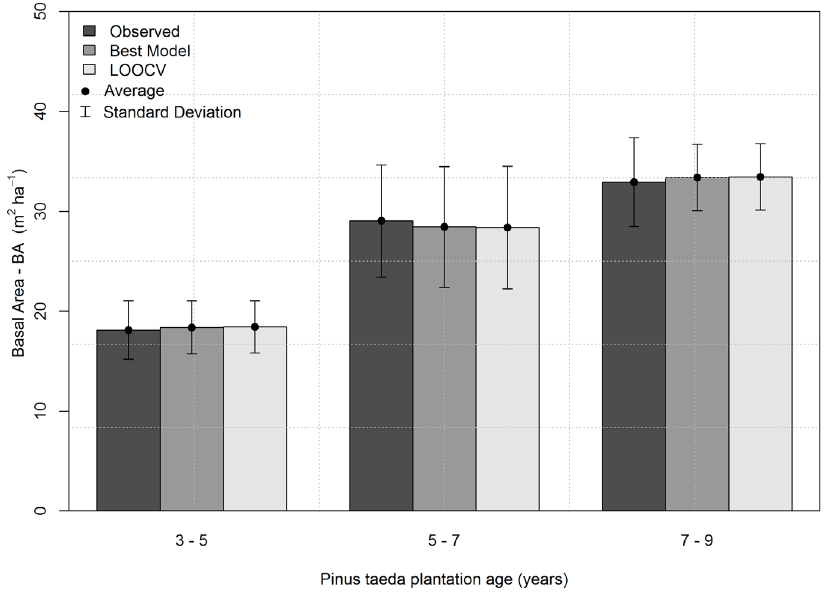
Figure 4 - Observed versus predicted BA (natural scale) from the best model and LOOCV across plantation ages for the sample plots (n=50).